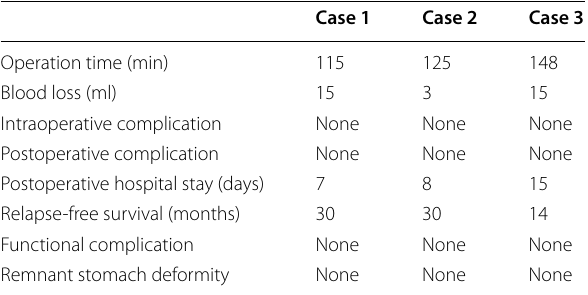
Table 2 Surgical